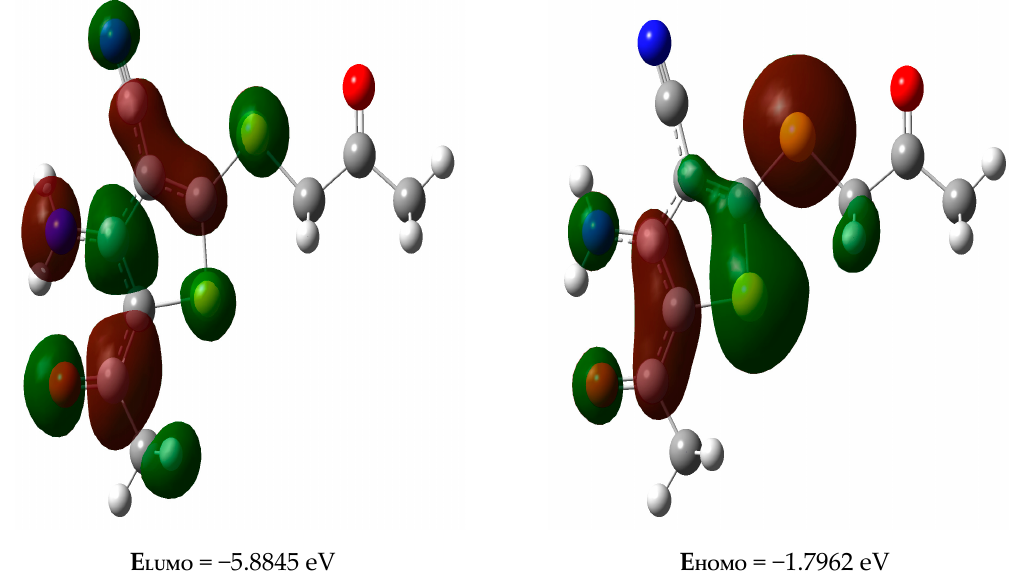
Figure 5. The ground state isodensity surface plots for the frontier molecular orbitals.